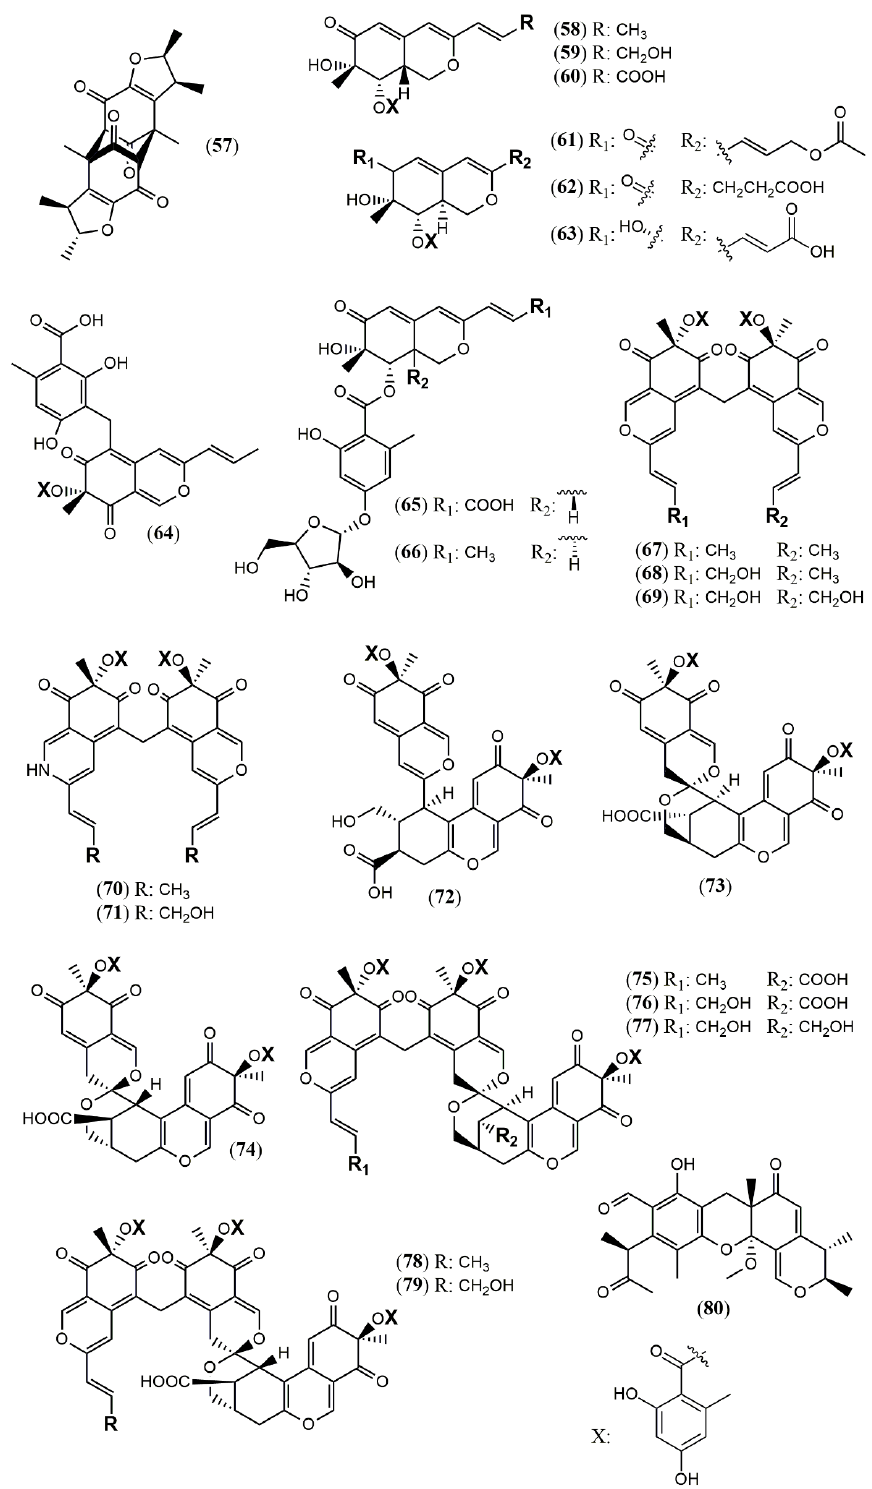
Figure 6. Chemical structures of Penicillium azaphilones : 57 : penicitrinone G; 58–64 : Dangelones A– G; 65–66: dangelosides A and B; 67–74 : didangelones A–H; 75–79 : tridangelones A–E; 80 : penc-